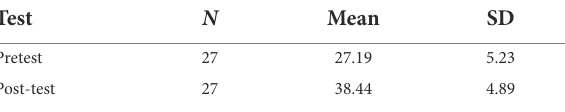
TABLE 4 Paired samples t-test for the experimental group.